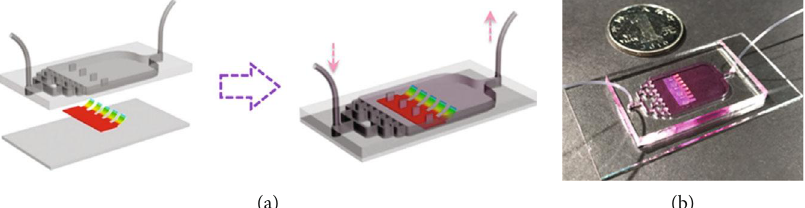
Figure 19: The applications of the biohybrid structural color hydrogels in a heart-on-a-chip system. (a) Schematic of the construction of the heart-on-a-chip by integrating the biohybrid structural color hydrogel into a bifurcated micro fl uidic system. (b) Image of the biohybrid structural color hydrogel integrated heart-on-a-chip. Reproduced (or adapted) with permission [99], ©2018, American Association for the Advancement of